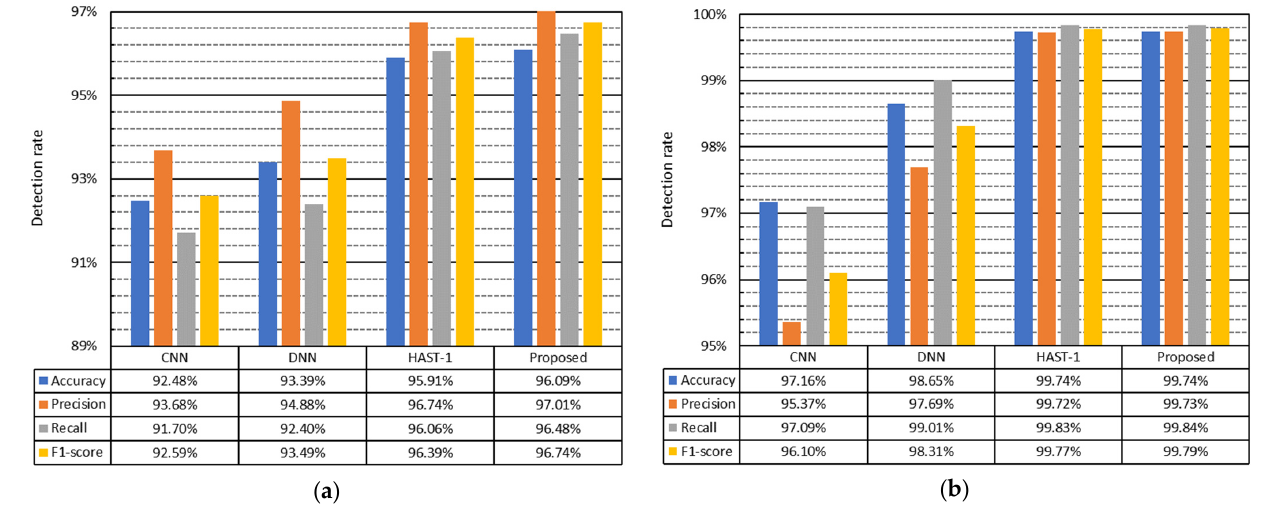
Figure 4. Comparison of intrusion detection rates for each NIDS using each dataset. ( a ) ISCXIDS2012; ( b ) CIC-IDS2017.